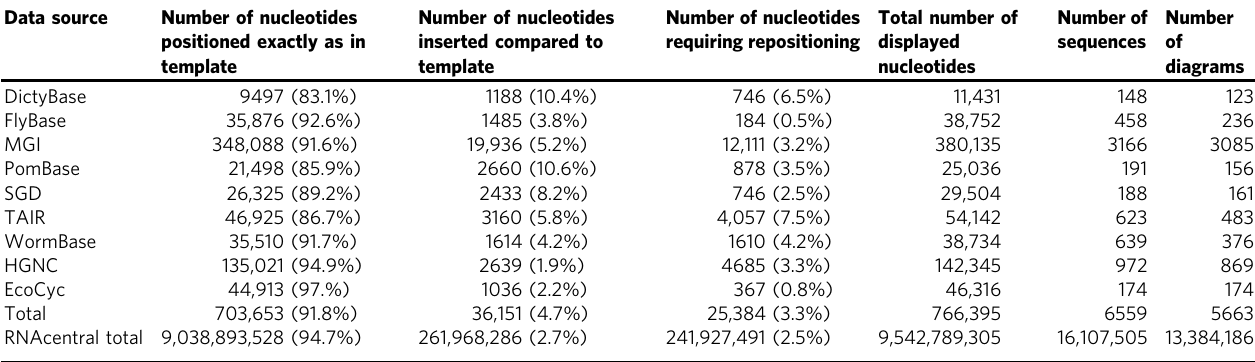
Table 2 Analysing the similarity between the R2DT diagrams and the templates.